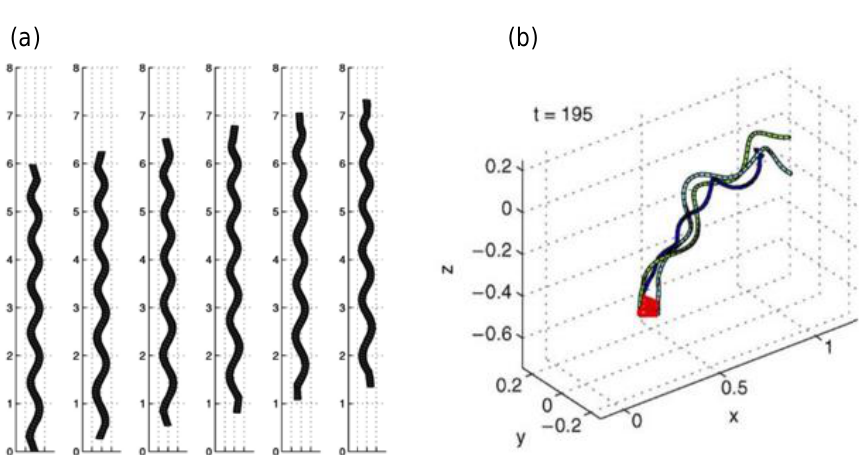
Figure 5. Illustration of the stokeslet method: ( a ) migration of the elastic spirochete, with permission from Cortez et al. [77], and ( b ) bundling of flagella, with permission from Flores et al. [78].